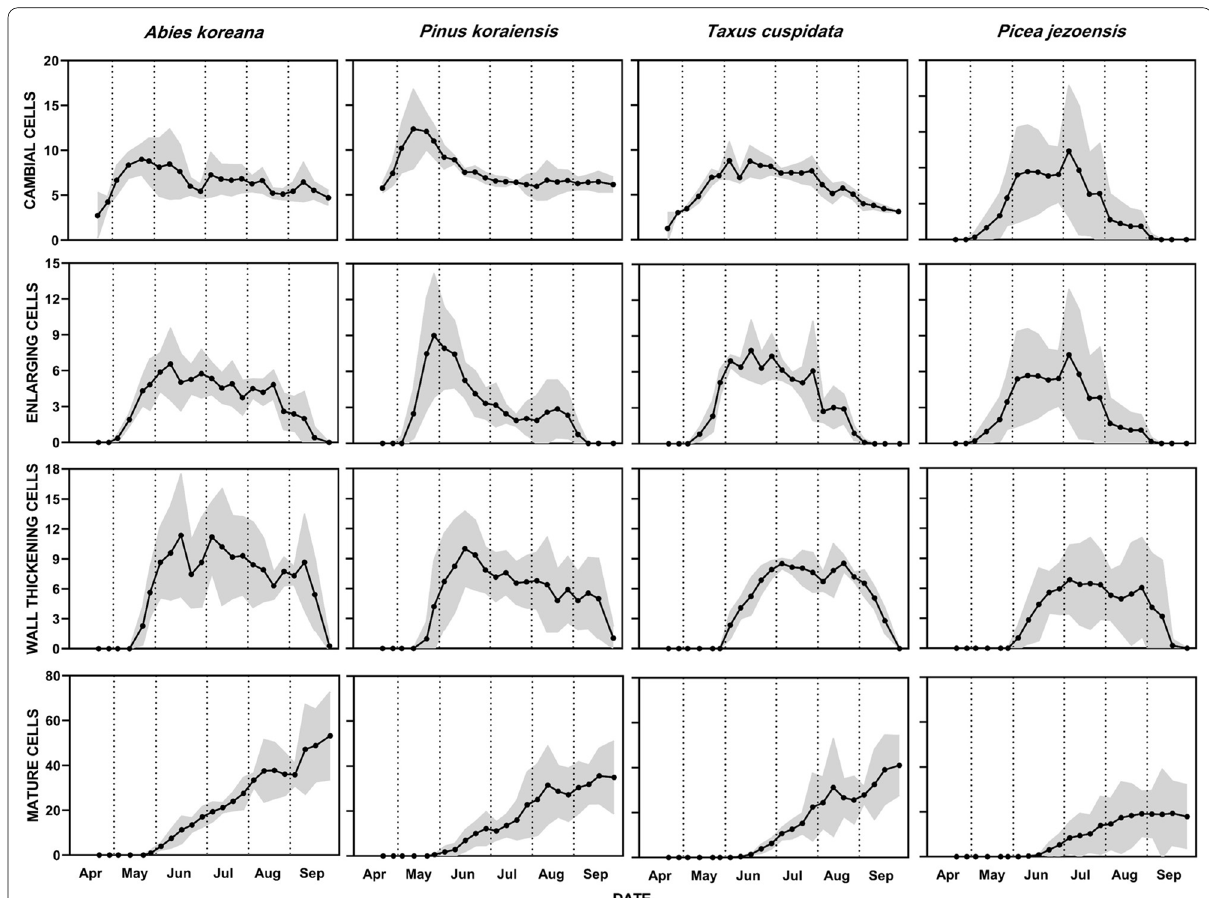
Fig. 6 Weekly variations in the number of cells in the cambial zone and during the different phases of xylem differentiation in 2017 (dots and grey background: the means standard deviations of the sample trees per sampling ±